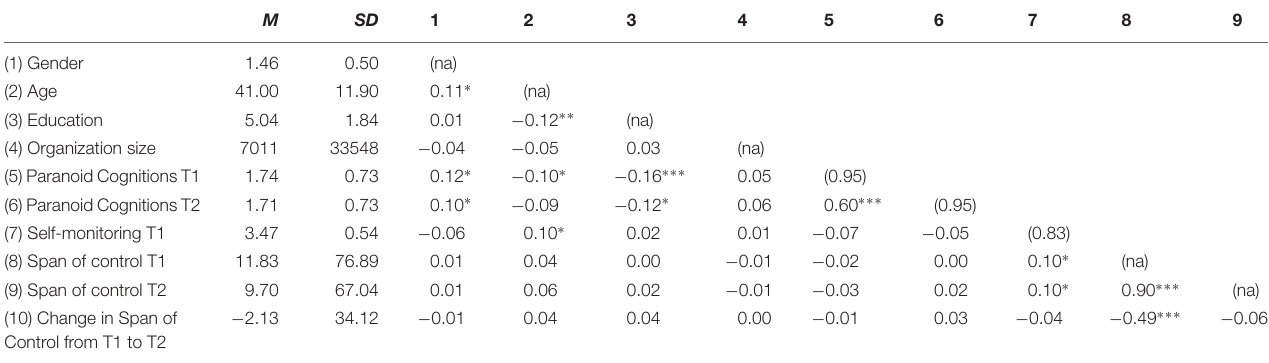
TABLE 1 | Descriptives, intercorrelations, and internal